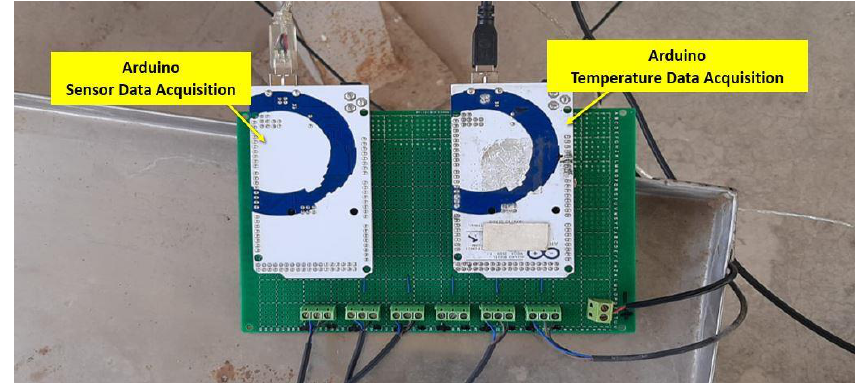
Figure 15. Arduino Mega 2560 integrated on Vero board for data acquisition.